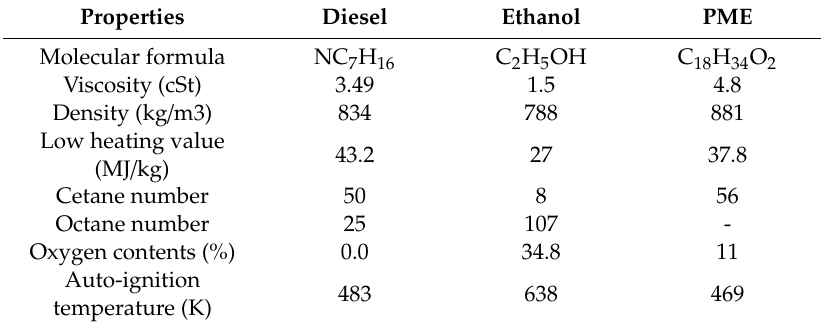
Table 1. Thermophysical properties of diesel, ethanol, and palm oil methyl ester (PME)